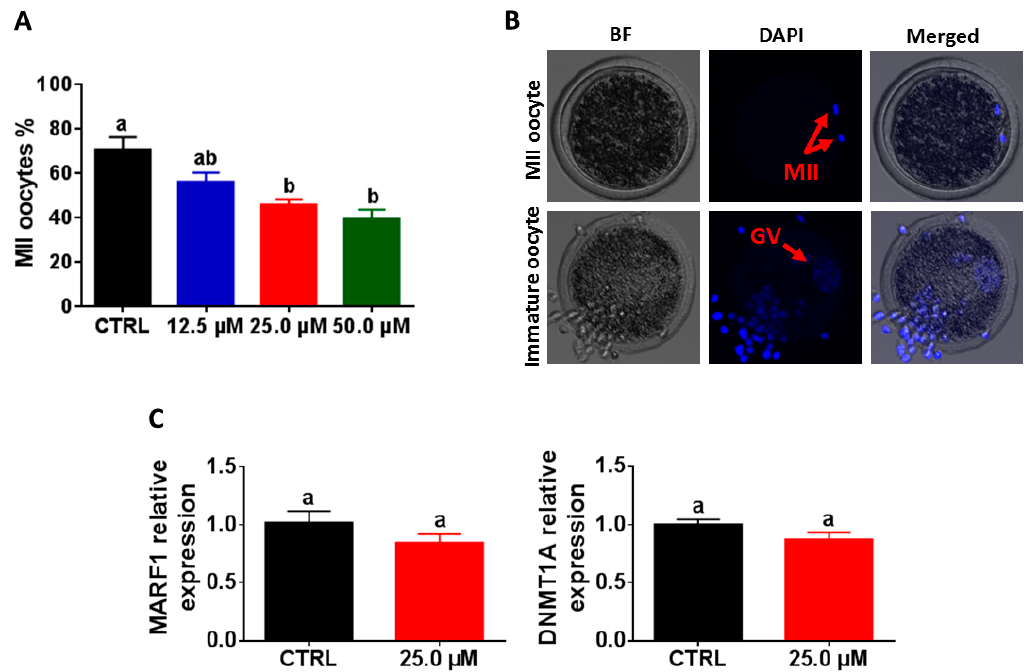
Figure 2. The effect of juglone on oocyte maturation. ( A ) The percentage of mature oocytes. ( B ) DAPI staining of nuclear material of MII and immature oocytes. ( C ) The expression pattern of maturation genes inspected by RT–qPCR. BF: bright field. Original magnification 100×. The different letters on the columns reflect statistical significance ( p < 0.05).